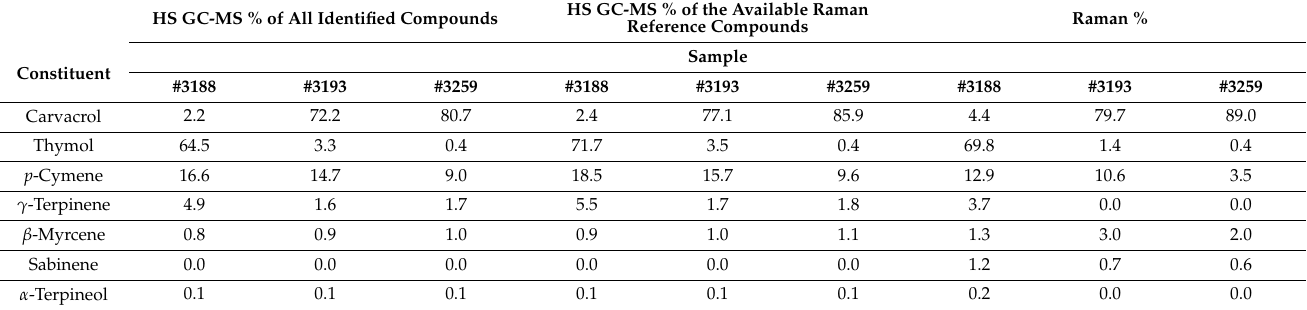
Table 2. Percentage fractions of the reference compounds in samples #3188, #3193 and #3259 obtained by the HS GC-MS and Raman analytical techniques. HS GC-MS results refer to the percentage of peaks’ area either over the total peaks’ area of the identified compounds or that of the available reference